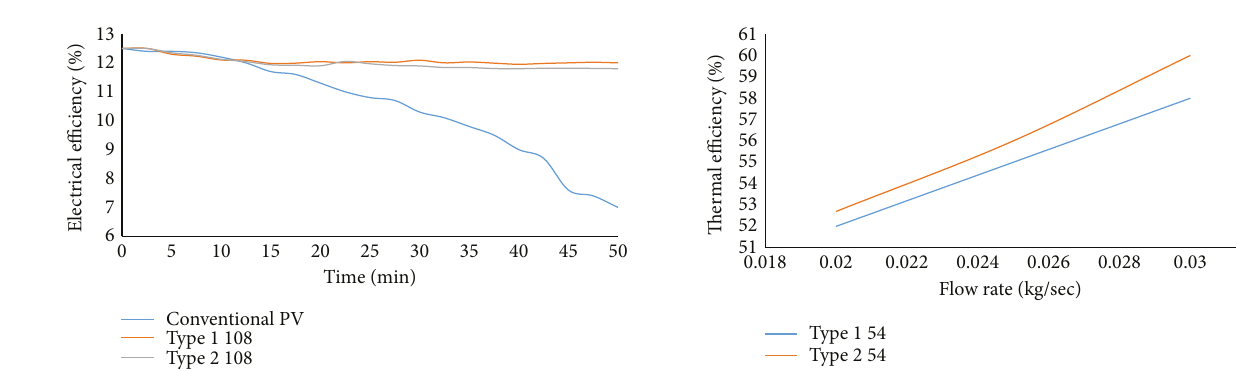
Figure 8: Variation of thermal e ffi ciency versus fl ow rate (kg/s) for 54 pc arrangements.